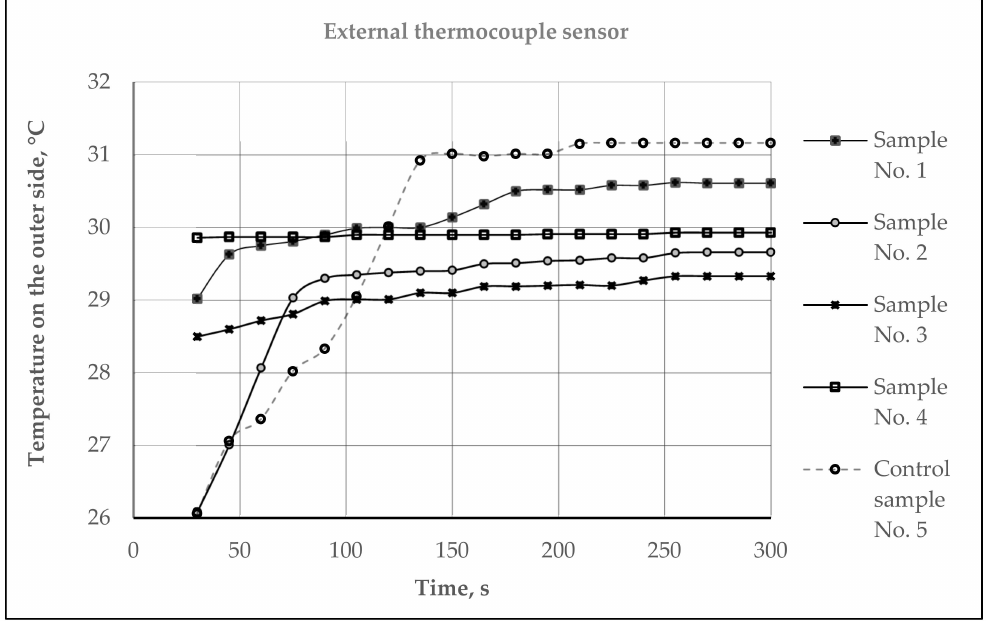
Figure 10. Dynamic curves of the heat exchange temperatures of different structures of